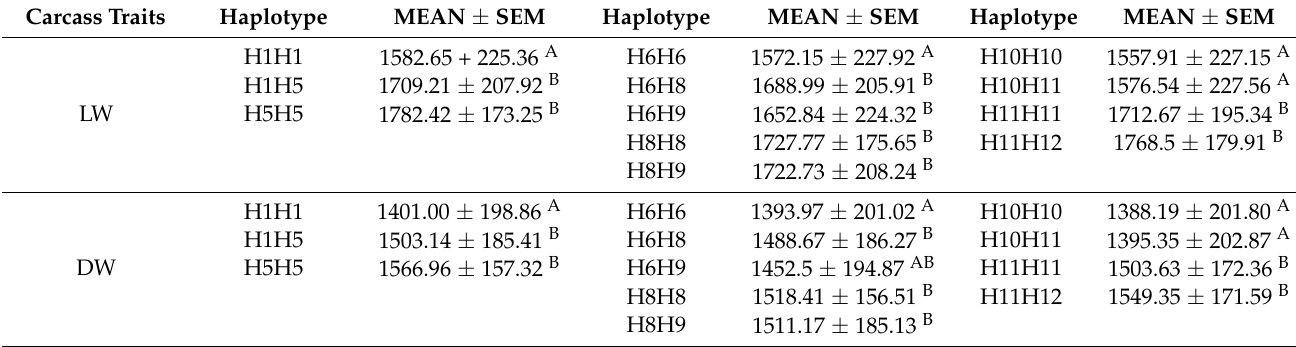
Table 6. Association analysis of haplotypes of G0S2 SNPs with carcass traits (MEAN ±